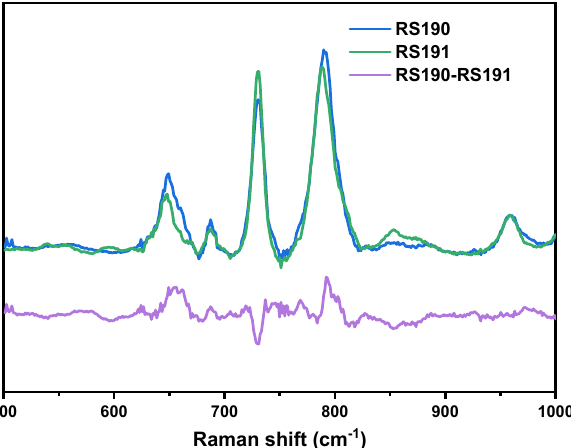
Figure 3. The normalized Raman spectrum and difference spectrum of the beta–thalassemia–related DNA sequence.